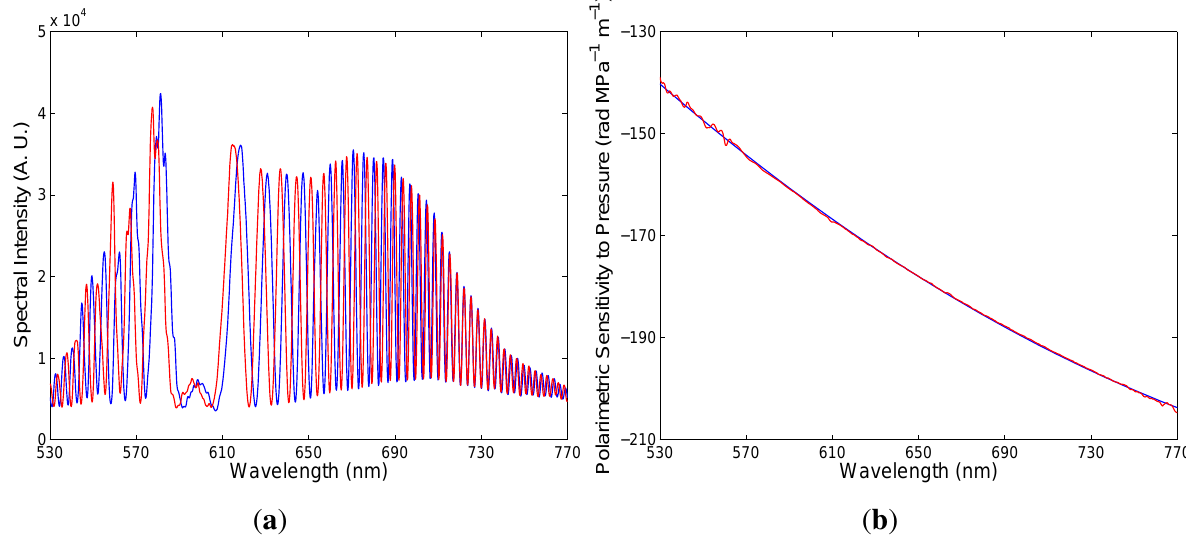
Figure 9. Two recorded spectra corresponding to the first delay and hydrostatic pressures, p = 0 . 72 MPa (blue) and p = 1 . 05 MPa (red) ( a ). The spectral dependence of 1 2 the polarimetric sensitivity to hydrostatic pressure ( b ). The red line is the approximate quadratic